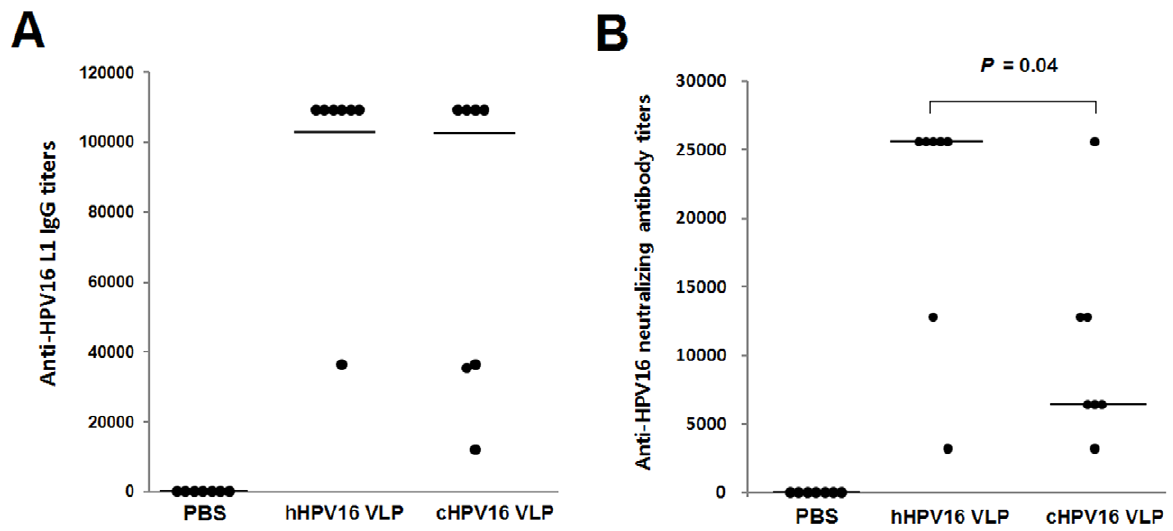
Figure 6. Immunization Protocol-2 Anti-HPV16 L1 IgG and neutralization antibody titers. The anti-HPV16 L1 IgG and anti-HPV16 neutralizing antibody titers of the PBS-, hHPV16 VLP- and cHPV16 VLP-immunization groups are presented in panels A and B, respectively. For the immunizations, the mice were subcutaneously injected three times with 100 m l of PBS, 1000 ng of hHPV16 VLP or 1000 ng of cHPV16 VLP at two- week intervals (protocol-2 in Table 2). The anti-HPV16 L1 IgG and anti-HPV16 neutralizing antibody titers were determined by ELISA and SEAP-based neutralization assays, respectively. The data values of seven individual mice (n=7) are represented with dots. The horizontal bars indicate the median titers of the anti-HPV16 L1 IgG and neutralization antibodies. (Table 2). In protocol-3, to investigate the lymphoproliferative responses elicited by immunizations with the two kinds of HPV16 VLPs, the mice were immunized two times at two-week intervals with 1000 ng of hHPV16 VLPs or cHPV16 VLP, in combination with aluminum hydroxide (200 m g per dose, Table 2). The immunization doses were based on a previous report [27]. Ten days after the last boost injection, splenocytes were obtained from each group for flow cytometry analysis. Sera were obtained by centrifugation of whole blood, and stored at 2 70 u C until analysis.